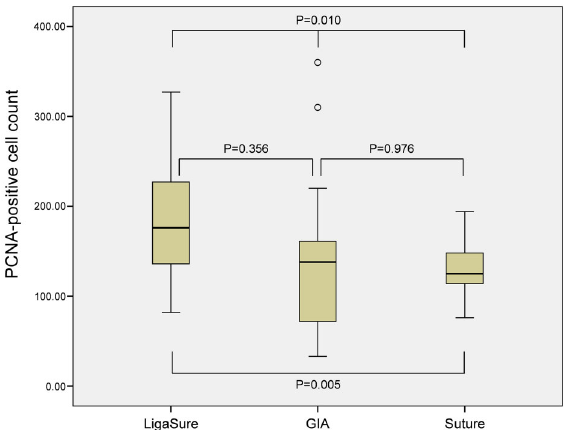
Figure 5. Analysis of proliferating cell nuclear antigen (PCNA)- positive cells. The mean number of PCNA + cells in each group was as follow: 181.97 in the LigaSure group, 142.60 in the GIA group, and 132.80 in the suture group. Data are reported as medians and interquartile ranges (Welch ’ s analysis of